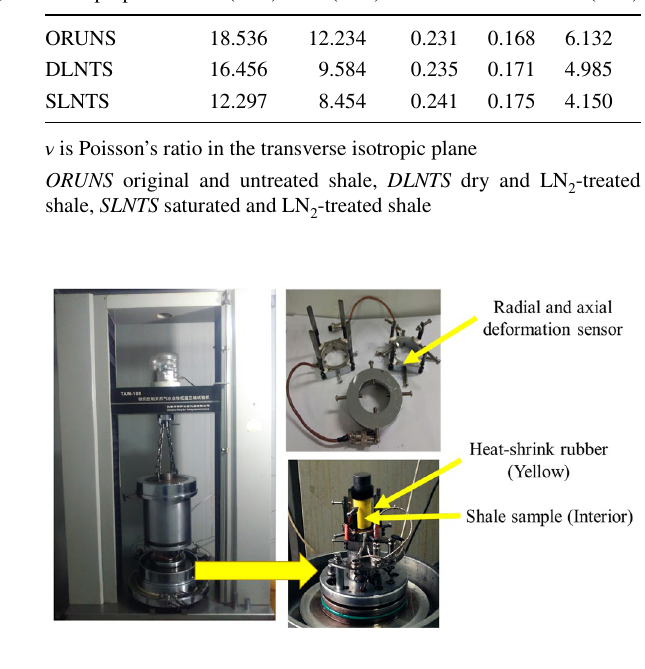
Table 1 Basic elastic constants of shale samples